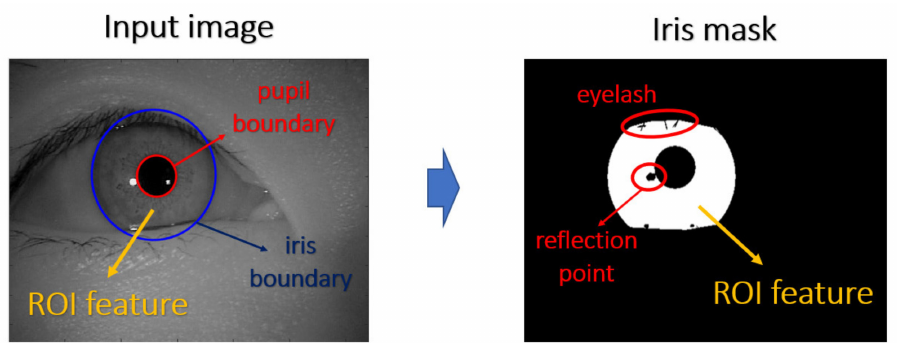
Figure 3. Iris mask labeling for